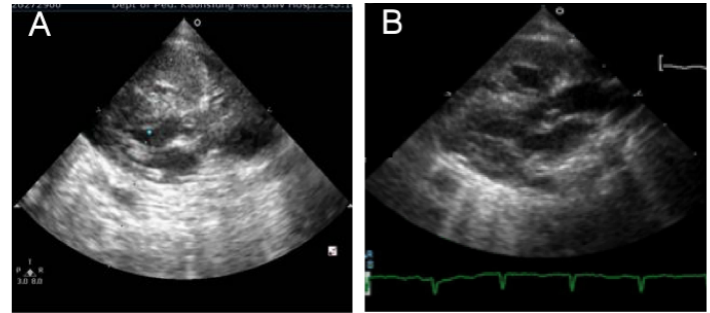
Figure 5. Long-axis echocardiographic image in a 1-day-old female newborn revealed a hyper- trophic right ventricle without patent ductus arteriosus noted ( A ), which improved 5 days later ( B ).